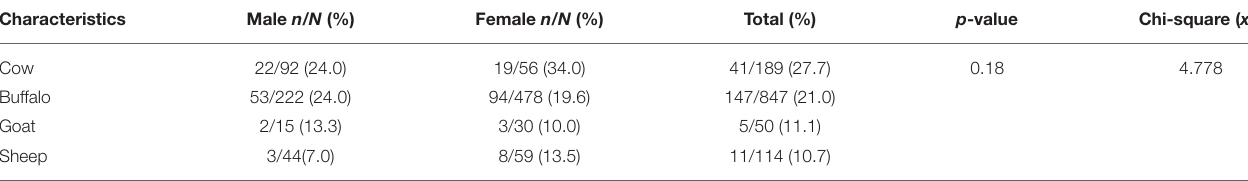
TABLE 1 | Prevalence of cystic echinococcosis among different slaughtered animals. Characteristics